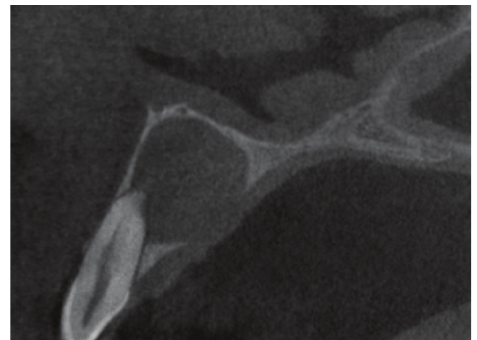
Figure 30: Pre-operative CBCT image in sagittal plane.